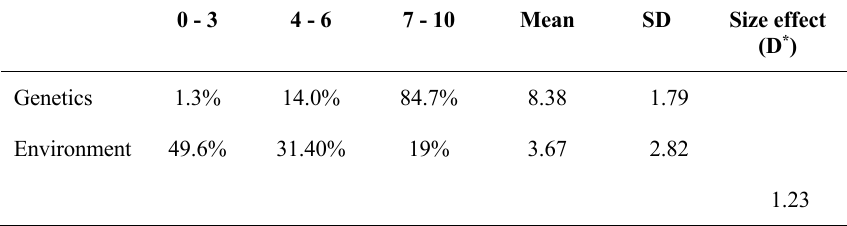
Percentage of responses, mean, standard deviation and size of the numerical effect on the influence of genetic and environmental influence on mental disorder (n=501 ).